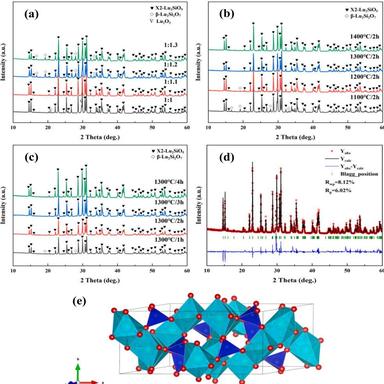
XRD patterns of X2-Lu2SiO5 nanostructured feedstocks after sintering: (a) in different mole ratios (b) at different temperatures for 2 h (c) for different times at 1300 ◦C (d) Rietveld refinement of XRD data of X2-Lu2SiO5 feedstocks and (e) crystal structure of X2-Lu2SiO5.